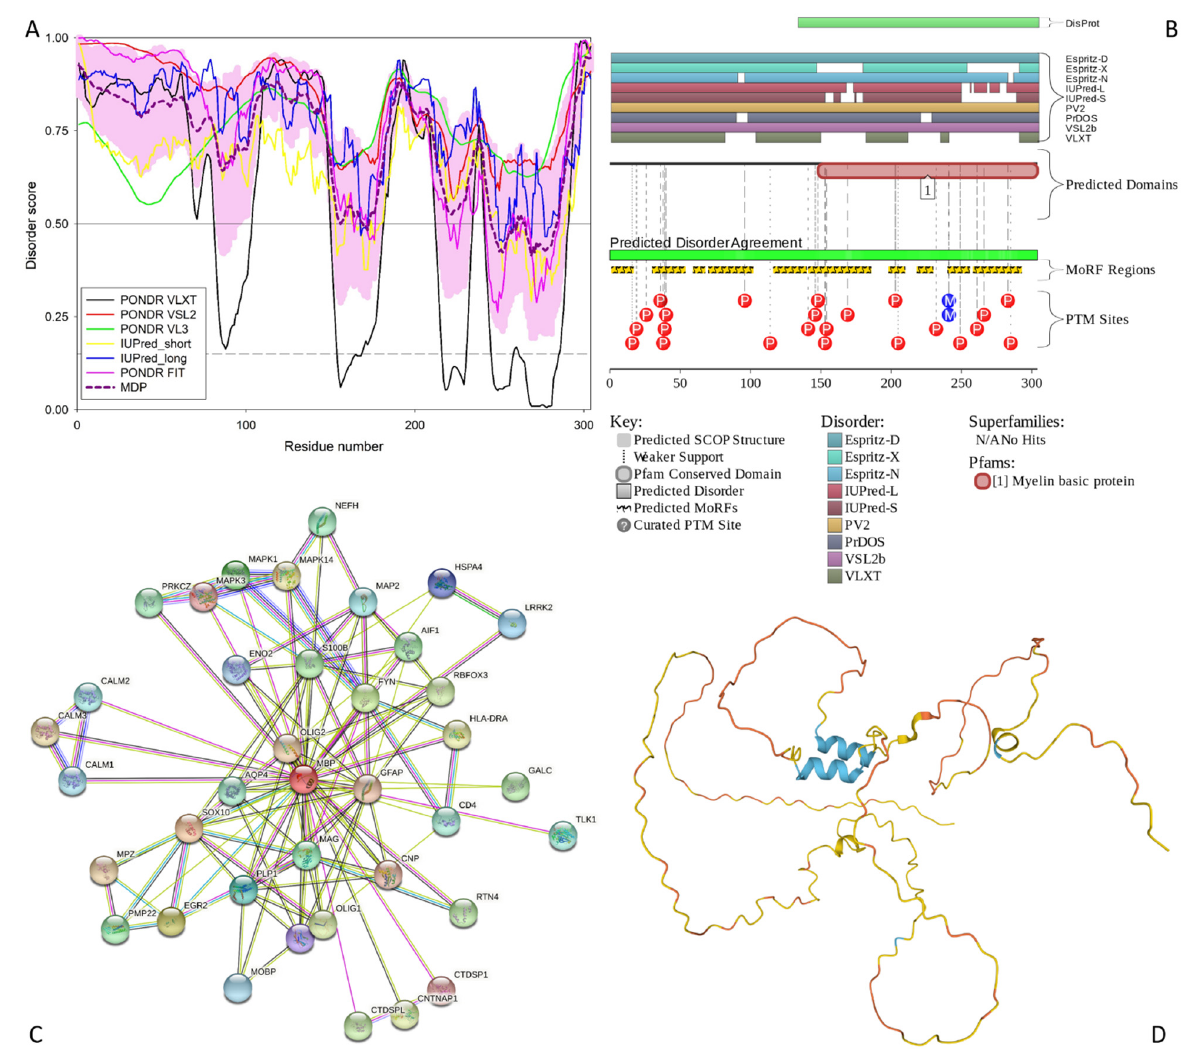
Figure 5. Functional disorder analysis of the myelin basic protein (MBP; UniProt ID: P02686). ( A ) Per ‐ residue disorder profile generated by RIDAO. ( B ) Functional disorder profile produced by the D 2 P 2 platform. ( C ) STRING ‐ generated PPI network centered at MBP. ( D ) 3D structure modeled for MBP by AlphaFold. Structure is colored based on the pLDDT values, where segments predicted with very high (pLDDT > 90), high (90 > pLDDT > 70), low (70 > pLDDT > 50), and very low (pLDDT < 50) confidence are shown by blue, cyan, yellow and orange colors, respectively.